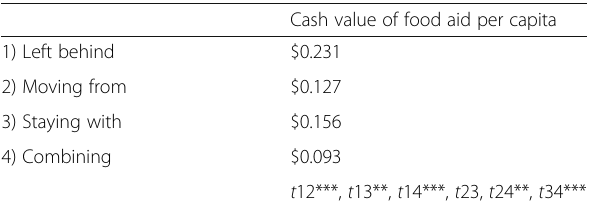
Table 7 The cash value of food aid per capita per day by HH group Cash value of food aid per